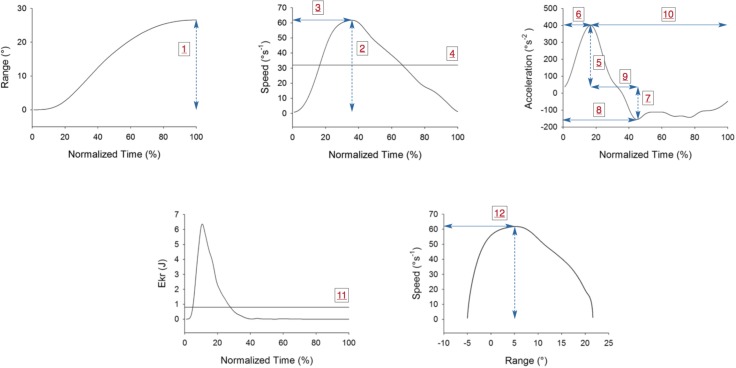
Typical plots of variables analyzed during one right rotation in a participant of the Younger adult’s group (age: 22 yrs, sex: female).All values are in absolute value. (1) range of motion (°); (2) peak speed (° s-1); (3) time to peak speed (s); (4) average speed (° s-1); (5) peak acceleration (° s-2); (6) time to peak acceleration (time to achieve the peak of acceleration (s); (7) peak deceleration (° s-2); (8) time to peak deceleration (s); (9) time between peaks acceleration and deceleration (s); (10) time from peak acceleration to end of rotation (s); (11) Average rotational kinetic energy (J); (12) value of the angle when maximum speed is achieved (°).